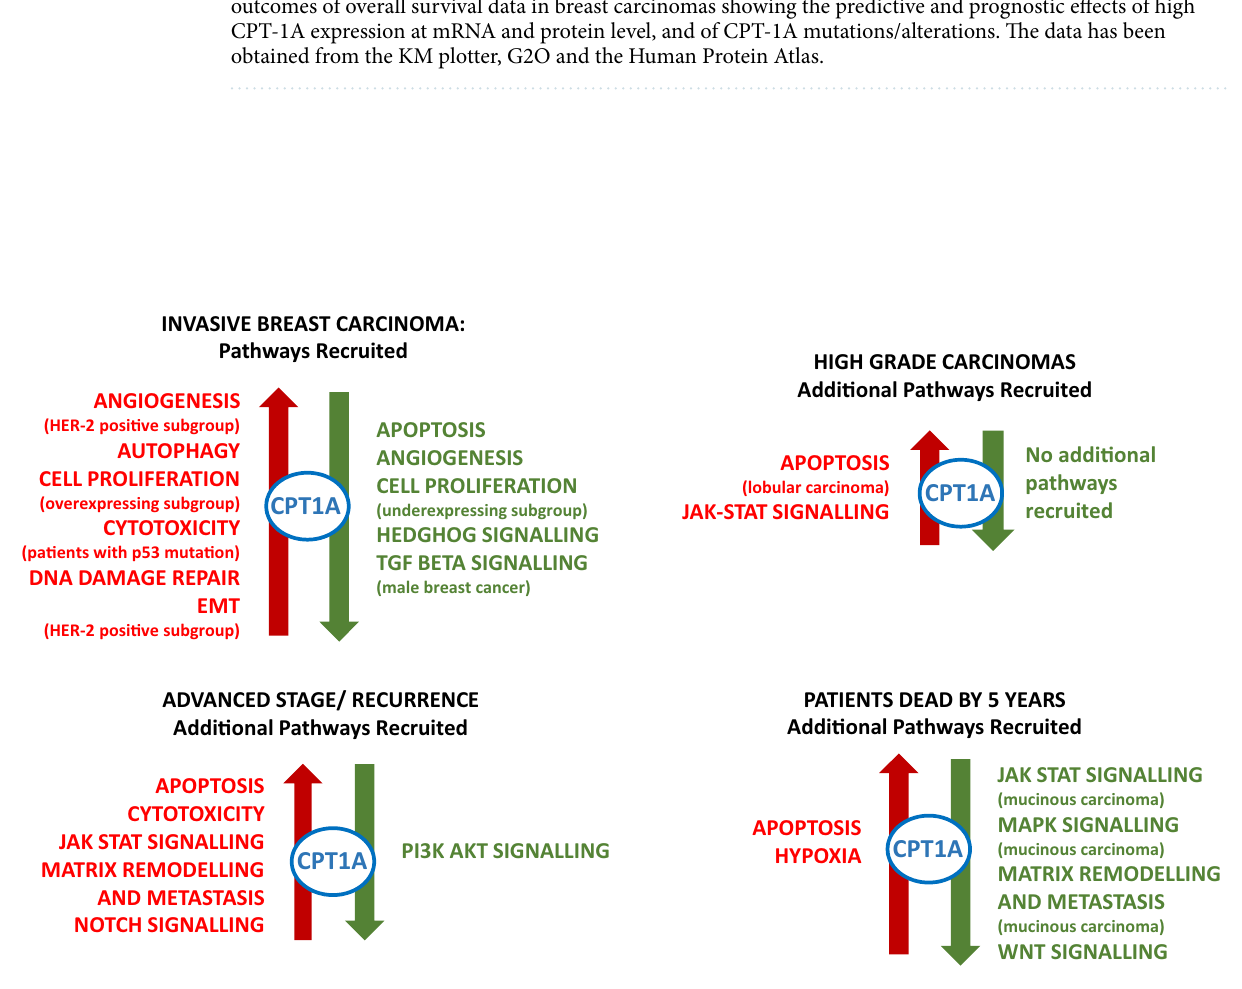
Figure 2. CPT1A clustering with cancer signalling pathways. Visual depiction of the clustering of CPT-1A with signalling pathways and whether the clustering occurs in the context of overexpression (red colour, left) or underexpression (green colour, right). The top left image shows the pathways which cluster with CPT-1A in the primary breast carcinomas. The remaining images show the additional pathways which cluster with CPT-1A in high grade carcinomas (top right), advanced stage or recurrence (bottom left) and in patients with a worse prognosis, as indicated by death by 5 years (bottom right). Where clustering is limited to a particular subgroup of carcinomas (defined by receptor status, histological subtype or the presence of p53 mutation), this is indicated in brackets beneath the signalling